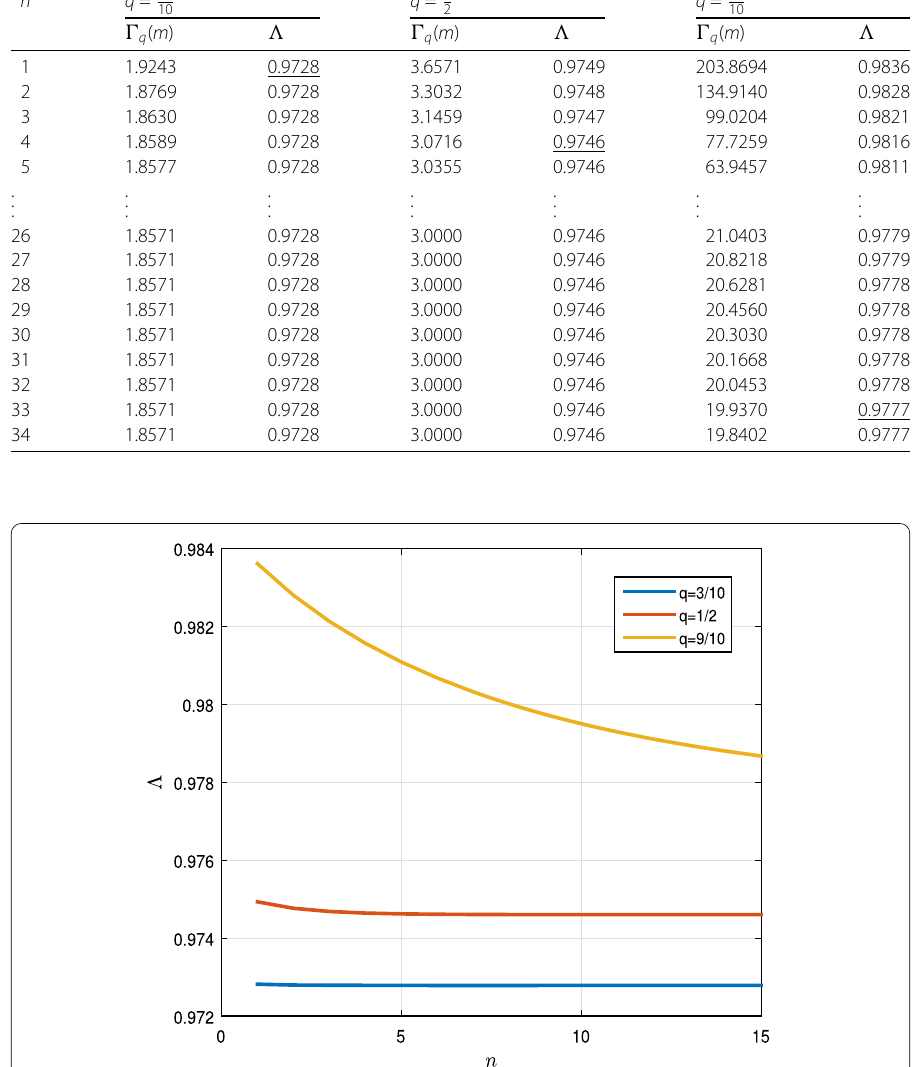
Table 1 Numerical results of (cid:12) q ( m ) and (cid:18) of F D q – DP (21) with q ∈ { 3